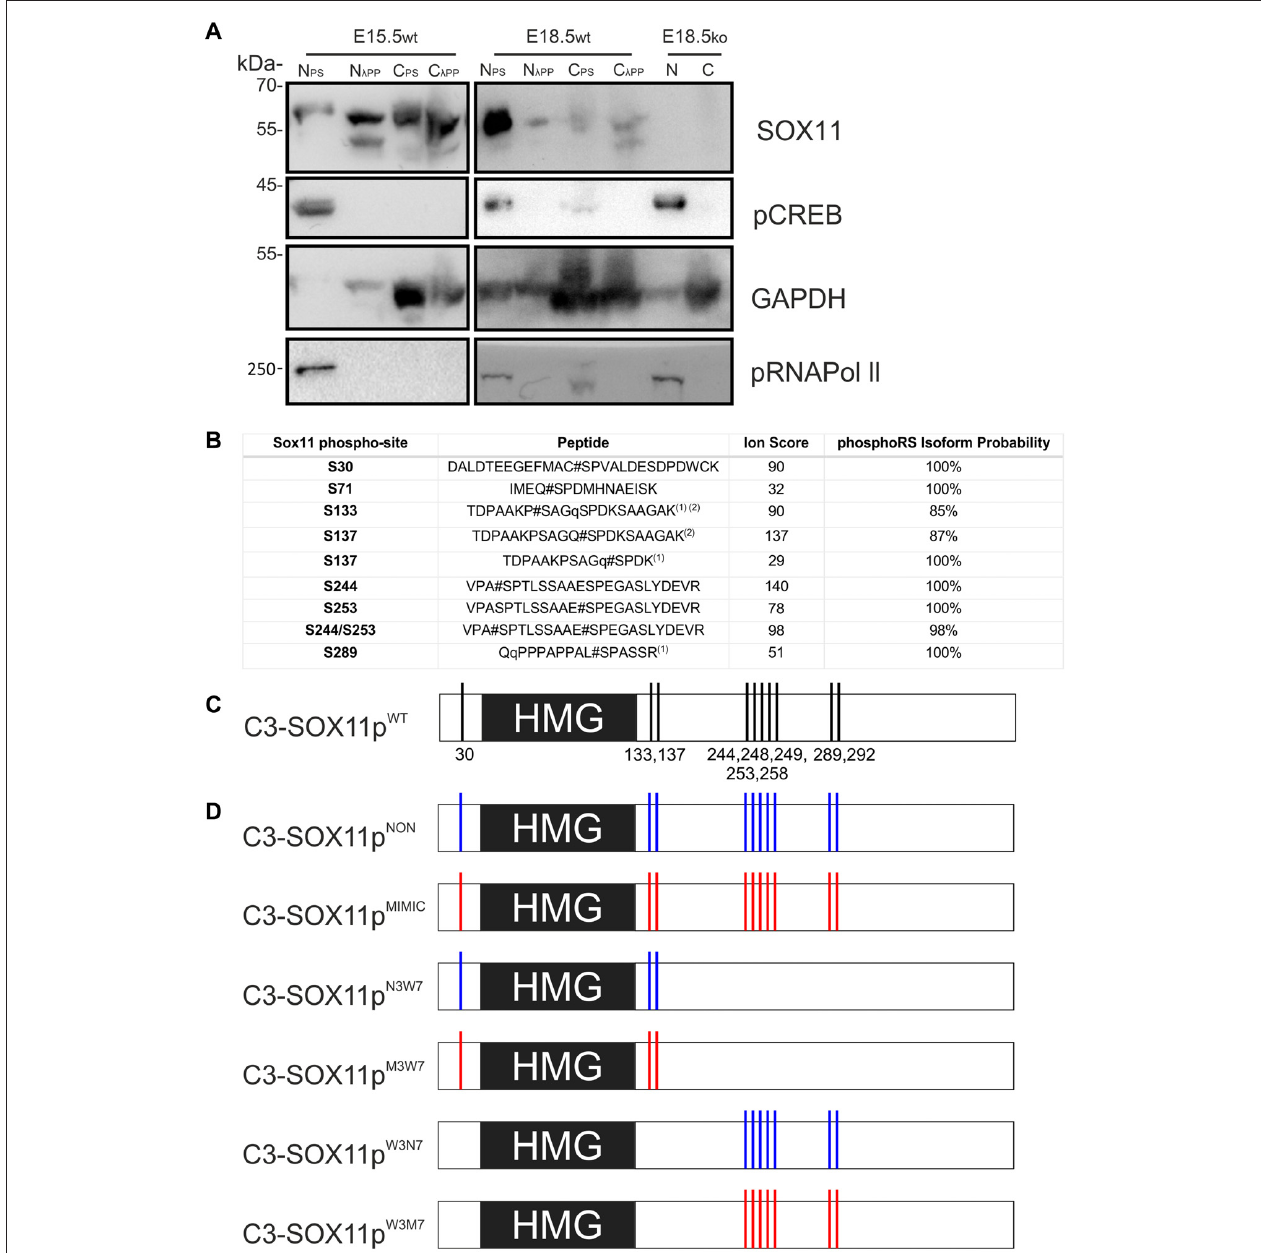
FIGURE 3 | SOX11 is phosphorylated in vivo and has at least 10 phospho-serines in vitro . (A) Western Blot analysis of nuclear (N) and cytoplasmic (C) extracts treated with Phospho Stop (PS) or lambda phosphatase ( λ PP) from E15.5 and E18.5 WT mice (wt) and Sox11 knockout mice (ko). First row: blotting with an anti-SOX11 antibody. Second row: blotting with an anti-pCREB (S133) antibody verifies the functionality of λ PP treatment and the enrichment of nuclear proteins. Third row: blotting with an anti-GAPDH validates the enrichment of cytoplasmic proteins. Fourth row: blotting with an anti-pRNA polymerase II validates enrichment of nuclear proteins and functionality of λ PP. E18.5, knock out for Sox11, brain extracts (E18.5ko) validates that the bands in the WT brains are specific for SOX11. Note the different band pattern of the SOX11 signal between E15.5 nuclear extracts treated with PS and λ PP. The SOX11 band pattern also appears to be changed by phosphatase treatment in E15.5 and E18.5 cytoplasmic extracts. (B) Identification of SOX11 phosphorylation sites by mass spectrometry. The table reports the SOX11 site, the peptide sequence, ion score and the phosphoRS metanalysis to identify the exact sites within the peptide sequence based on the MS/MS spectra. Peptides with highest site probabilities/ion scores have been selected from Supplementary Table S2 and contain peptides from both cell lines (N2A and HEK293T). All phosphopeptides were identified in both lines: (1) peptide with the highest peptide score contained a deubitquitination on Q(11)/Q(2) indicated by a small q; (2) peptides contain one missed cleavage. (C) Schematic representation of the putative phosphorylated serines on SOX11 protein. (D) Schematic representation of SOX11 mutants in which the serine residues that have been replaced by Alanine (NON-phosphorylatable amino acid) are marked with blue while the residues replaced by Aspartate (amino acid that MIMICS phosphorylation) are marked with